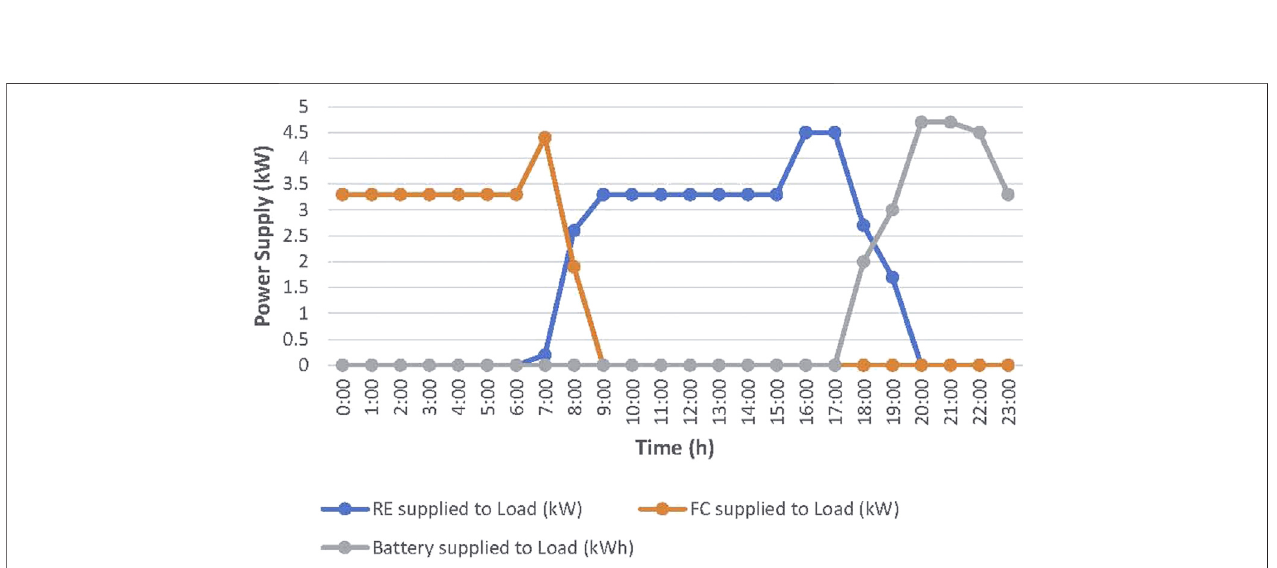
FIGURE 10 | Power Supplied by the Renewable Energy, Fuel Cell, and Battery to satisfy the Load Demand in Day 3